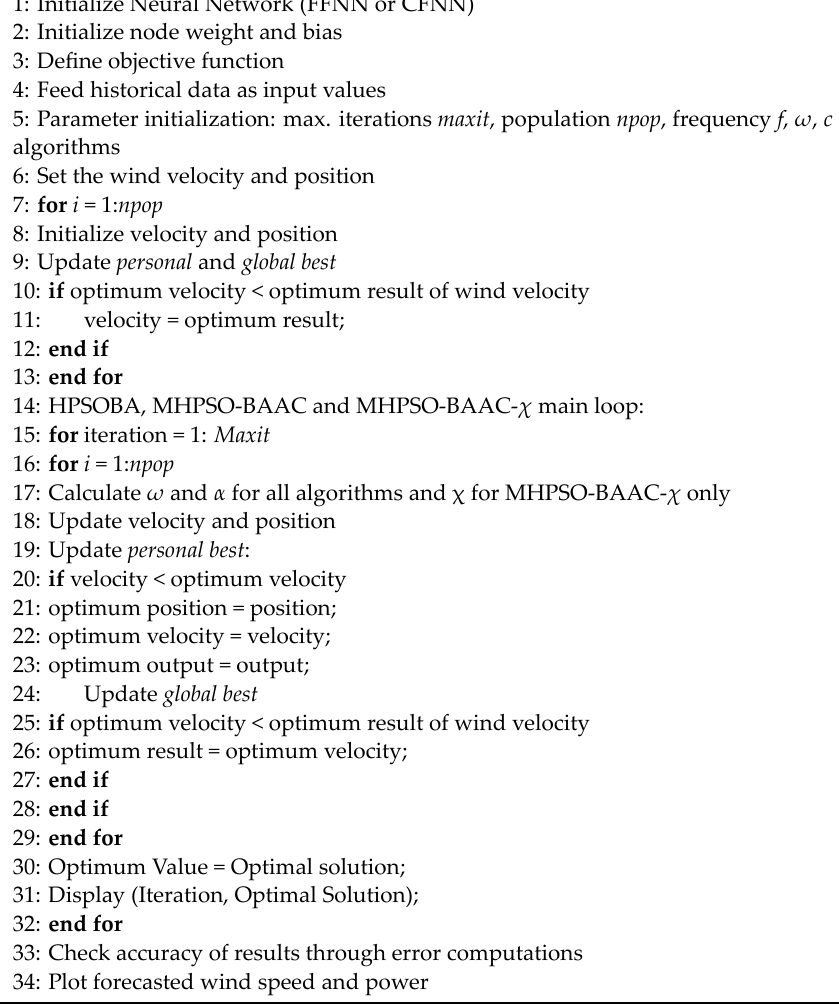
Algorithm 3. FFNN Trained Through HPSOBA and MHPSO‑BAACs